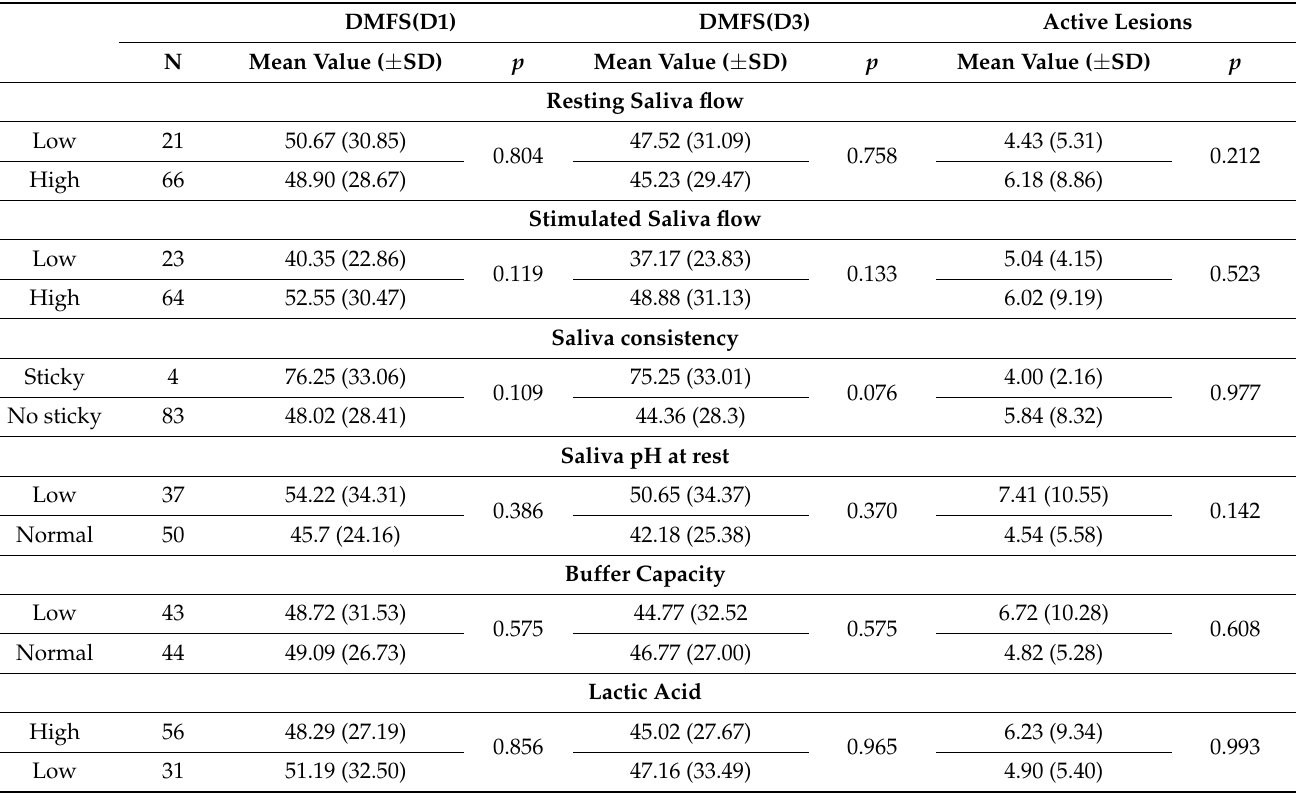
Table 2. Distribution of sample individuals per test parameter according to the DMFS index (D1), the DMFS index (D3) and the number of potentially active lesions.